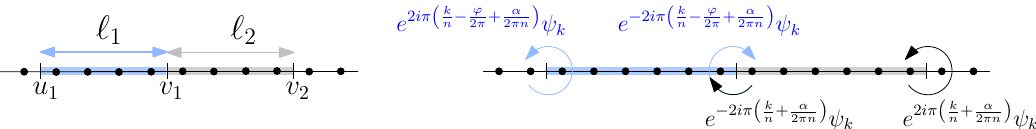
Figure 1: Tripartite geometry for two adjacent intervals. In the plot the interval A is the blue one on the left and A respectively. B is the reminder. The partial transpose is taken on A point, we report the phase taken by the field ψ